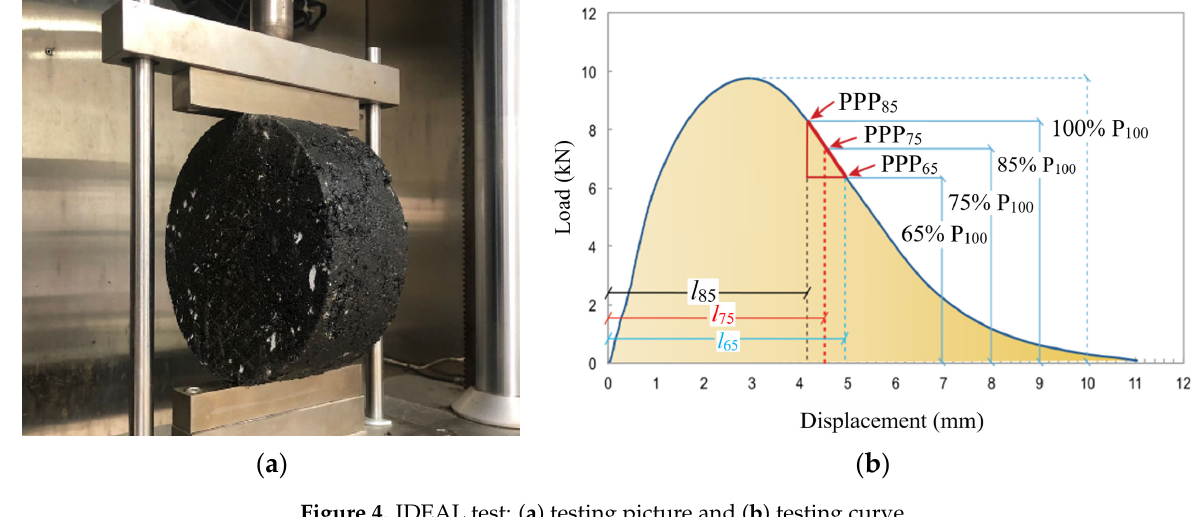
Figure 4. IDEAL test: ( a ) testing picture and ( b ) testing curve.